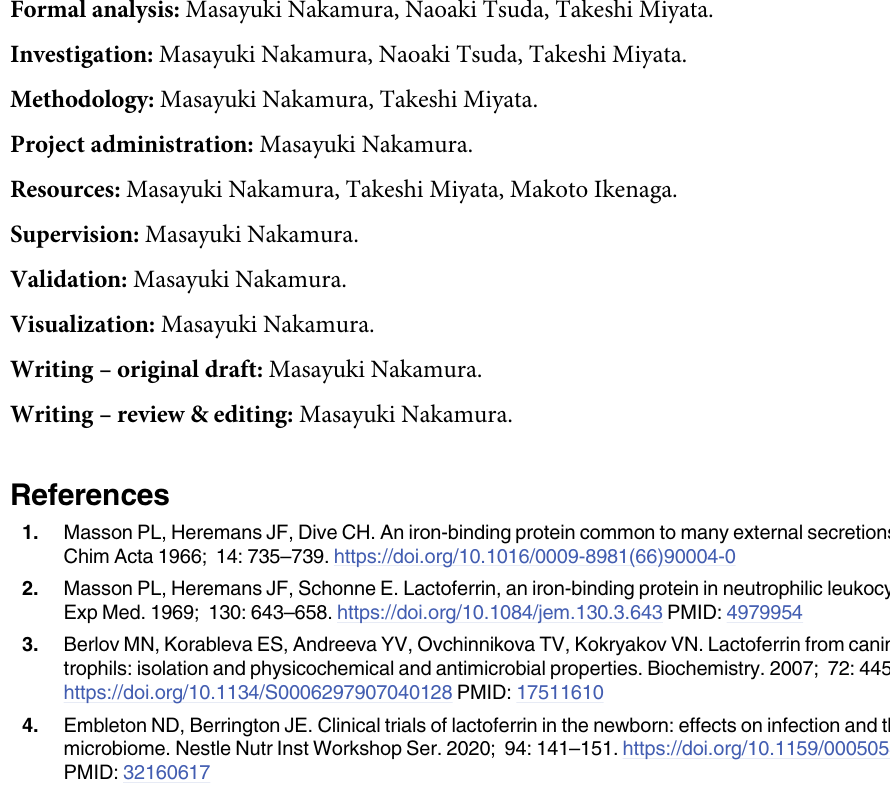
S1 Fig. Protein structure of bovine-derived lactoferrin (bLF) (PDB accession number: 1BLF). The lactoferricin region in bLF (LFcinB) is shown in red. The amino acid sequences of LFcinB and human-derived latoferricin (LFcinH) are shown. The sequence in the box is the core motif of LFcinB and is used for the assay of synthetic peptides. (TIF) S2 Fig. Fusion protein of mCherry-LFcinB expressed in Escherichia coli . Native PAGE was conducted, and the gel was illuminated with UV light so that the fluorescence of mCherry pro- tein could be detected (left). In native PAGE, mCherry-LFcinB (lane 2) appeared as broad bands because LFcinB, which is rich in cationic amino acids, affects the structure and mass-to- charge ratio of the fusion protein. SDS-PAGE was also conducted (middle). It is known that mCherry (DsRed) protein is fragmented at its chromophore group under the conditions of SDS-PAGE (Gross et al. 2000). The largest bands are of uncut proteins (about 30 KDa). Two other bands represent the cleaved fragments. Purified proteins were directly illuminated with UV light (right). Reference: Gross LA, Baird GS, Hoffman RC, Baldridge KK, Tsien RY. The structure of the chromophore within DsRed, a red fluorescent protein from coral. Proc